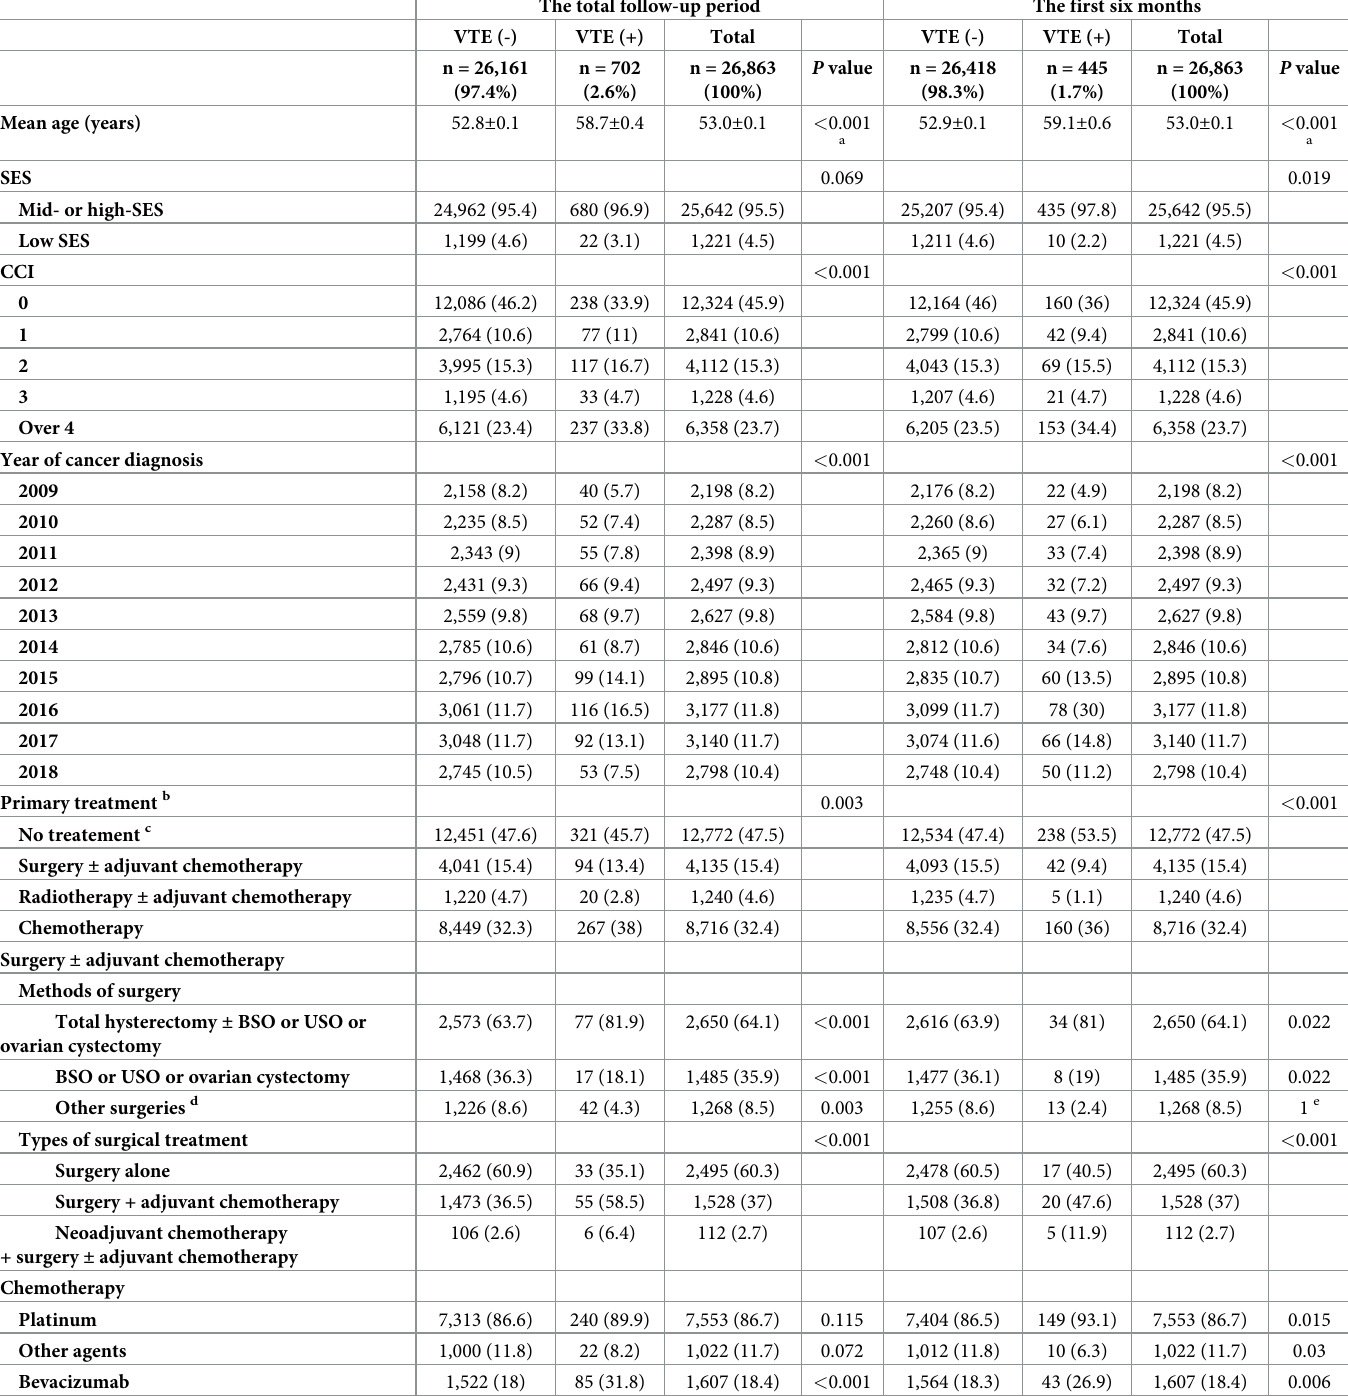
Table 1. Characteristics of women with ovarian cancer in HIRA claims data of